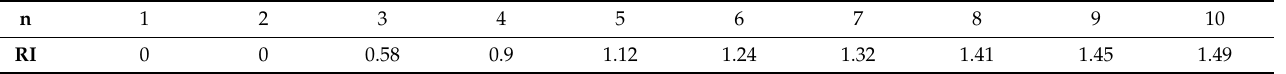
Table 7. Relationship between index (size of matrix and random consistency RI ).